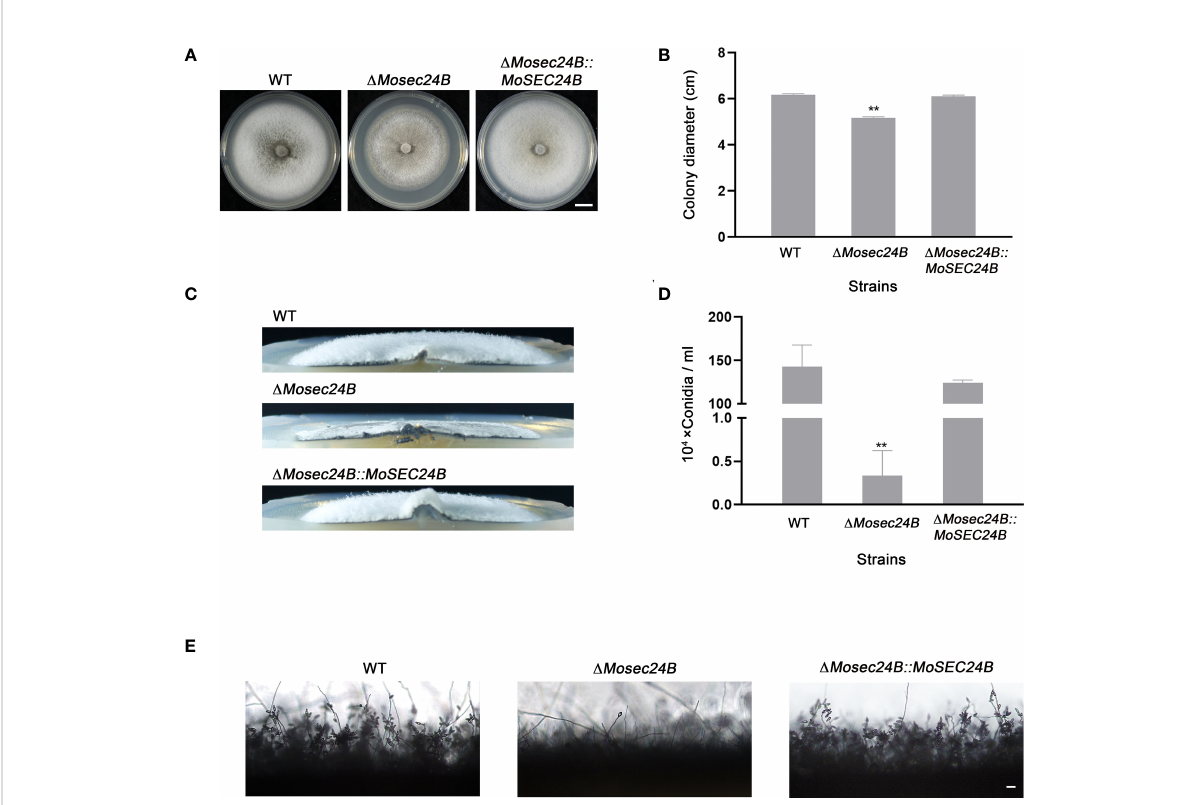
FIGURE 3 MoSec24B is involved in growth and conidiation. (A) WT, D Mosec24B , and D Mosec24B::MoSEC24B strains were cultured on CM solid medium for 8 days. Scale Bar = 1 cm. (B) Mycelial diameters of WT, D Mosec24B , and D Mosec24B::MoSEC24B strains. (C) Colony side views of aerial hyphae growth in WT, D Mosec24B , and D Mosec24B::MoSEC24B strains. (D) Conidiation of WT, D Mosec24B , and D Mosec24B::MoSEC24B strains. (E) Conidiophores of WT, D Mosec24B , and D Mosec24B::MoSEC24B strains were observed under a light microscope. Scale Bar = 50 m m. Error bars represent the standard deviation. An analysis of the data was carried out using an unpaired two-tailed Student ’ s t-test. Asterisks represent statistically signi fi cant differences in the data (**P <